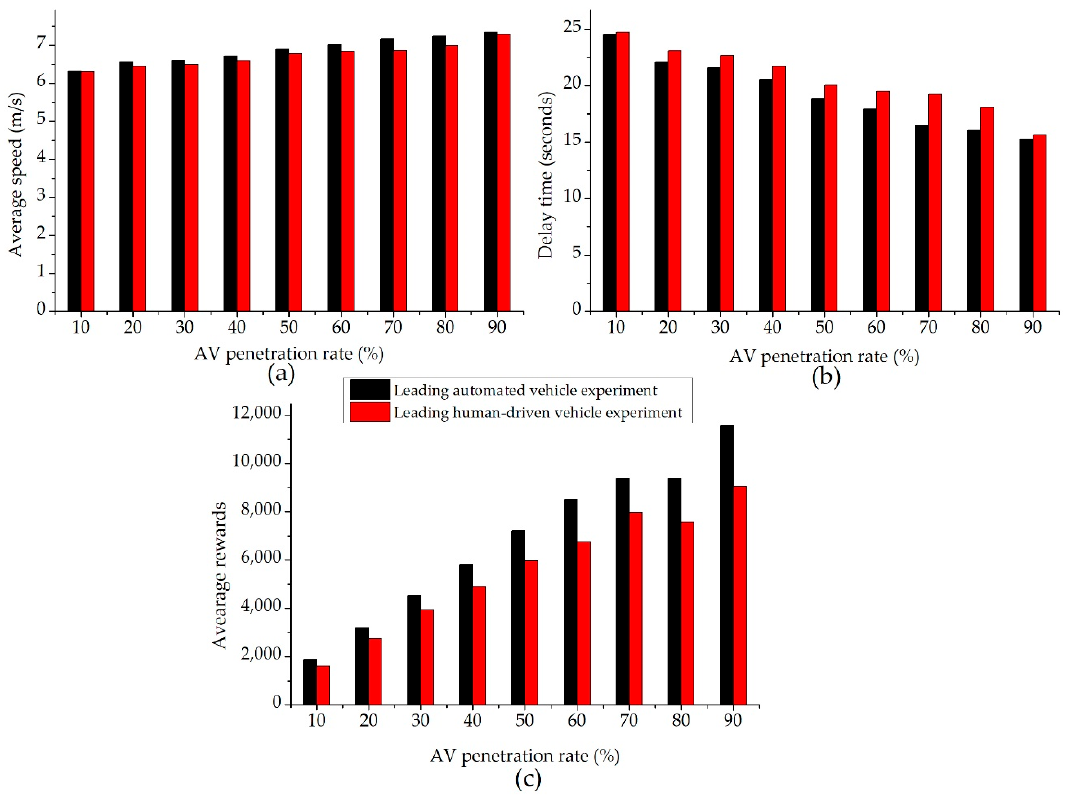
Figure 11. Comparison between the leading autonomous vehicle experiment and the leading human-driven vehicle experiment: ( a ) average reward vs. AV penetration rate; ( b ) average speed vs. AV penetration rate; and ( c ) delay time vs. AV penetration rate.